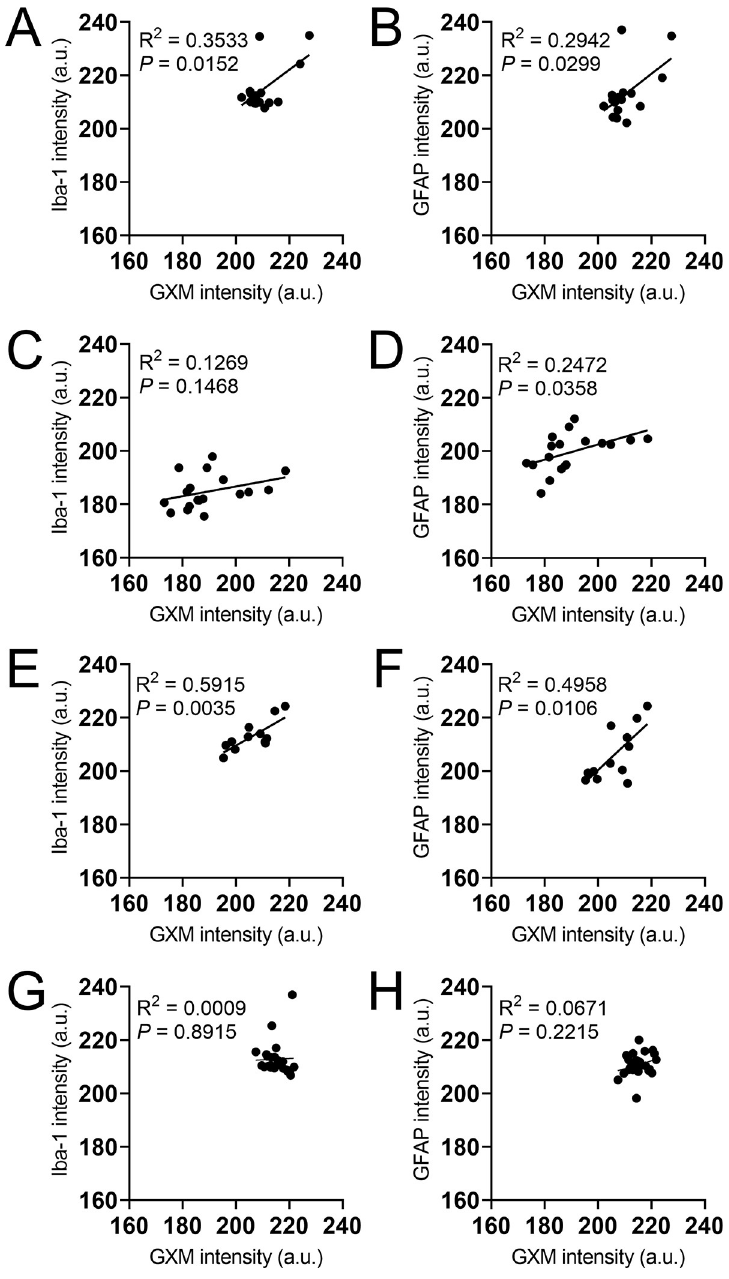
Fig 6. Glia distribution and GXM localization correlation vary depending on the brain region infection. Correlations between GXM localization and glial cell infiltration in brain tissue of mice infected with C . neoformans strain H99 cells in (A-B) bregma, (C-D) cortex, (E-F) striatum, and (G-H) ventricles. GXM, microglia, and astrocytes were stained with mAb 18B7, Iba-1, and GFAP, respectively. The intensity of each marker was analyzed in coronal tissue sections using the NIH Image J software. The R 2 and P values for each regression are also indicated. striatum, or ventricles using the NIH Image J software (Fig 6). Mice infected in bregma showed positive correlations between Iba-1 (R 2 = 0.3533; P = 0.0152; Fig 6A) and GFAP (R 2 = 0.2942; P = 0.0299; Fig 6B) stained cells and GXM distribution. Iba-1 and GXM (R 2 = 0.1269; P = 0.1468; Fig 6C) staining did not correlate in mice infected in the cerebral cortex, although